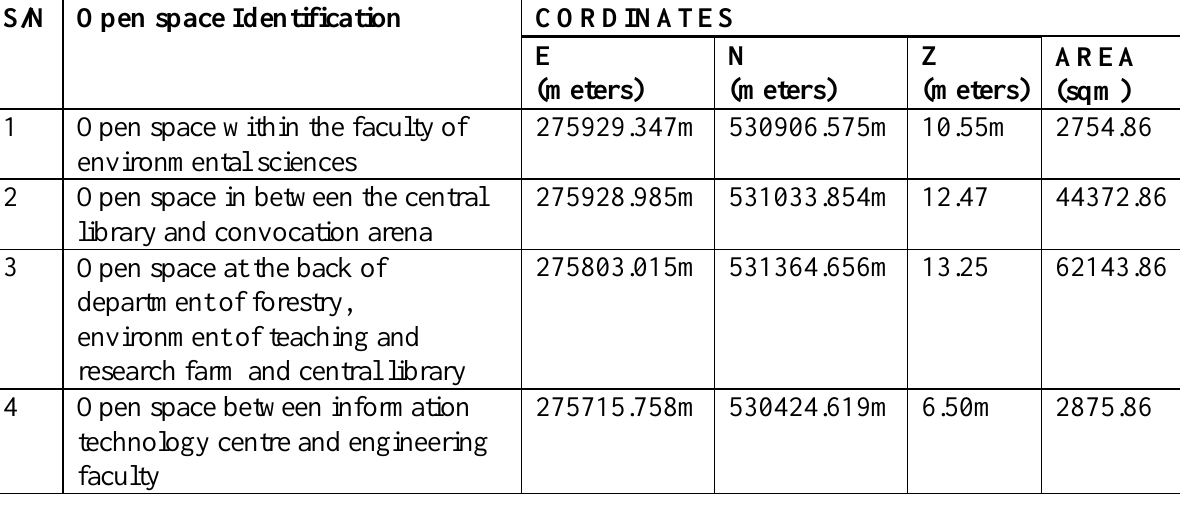
Table 2: Location and sizes of Open Spaces in Zone (B)